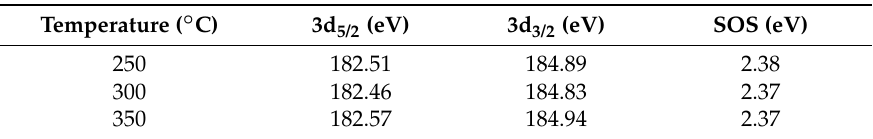
250 Figure 2. Compositions of ZrO 2 films grown at different temperatures. Figure 3. ( a ) O 1s and ( b ) carbon spectra of the ZrO 2 film grown at 300 °C. The measurements were performed after the film was etched for 1 and 10 min to analyze the composition of the film at the surface and in the bulk, respectively. Figure 4 shows the XRD patterns of the ZrO 2 films grown at 250–350 °C on TiN substrates. For the film that is grown at 250 °C, a small broad peak at 2 θ = 30.4° was observed, which was attributed to the tetragonal (111) reflection (JCPDS 14-0534). The ZrO 2 films grown at both 300 and 350 °C were polycrystalline with their XRD patterns containing peaks at 28.3°, 30.4°, 31.3°, 34.7°, and 35.3°. Regardless of the growth temperature, the dominant peak appeared at 30.4° and was consistent with the tetragonal phase. The other small peaks observed at 28.3° and 35.3° were, respectively, indexed as monoclinic ( − 111) (JCPDS 36-420) and a mixture of the tetragonal (200) and monoclinic (200)